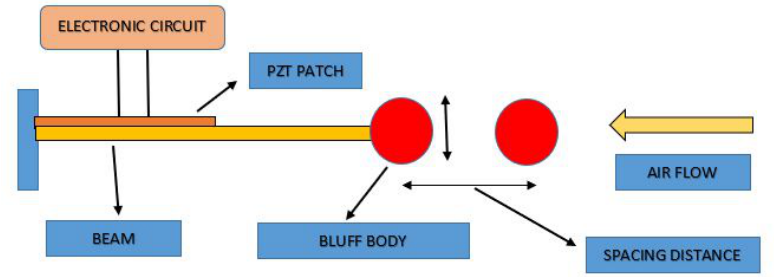
Figure 12. Wake galloping-based PEH schematic. Two bluff bodies are subjected to airflow. One is attached at the end of an elastic cantilever beam and another bluff body is placed in front of